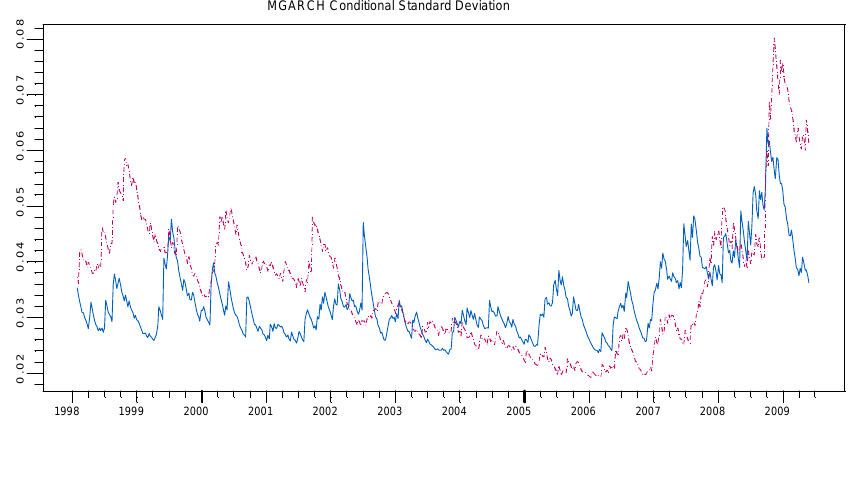
MGARCH Conditional Standard